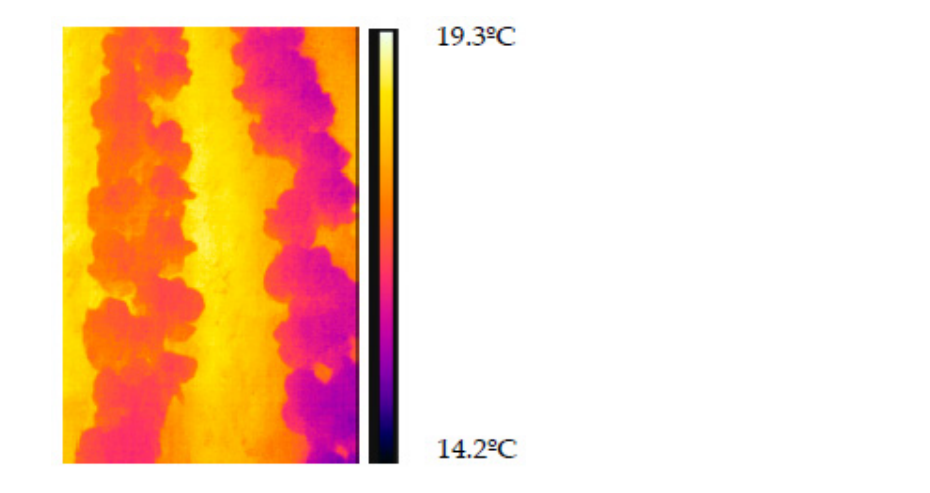
Figure 2. Thermal image examined using FLIR Tools to illustrate temperature variations between the SP row on the right and the CP row on the left in T3.